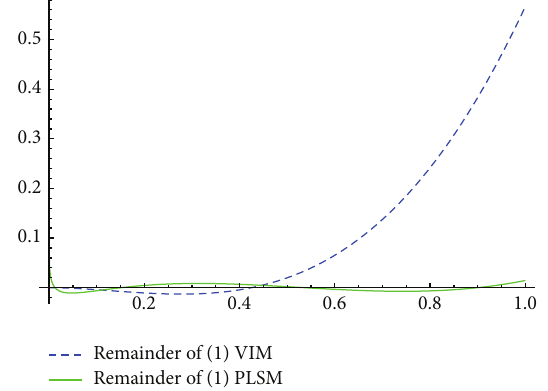
Figure 3: The remainders corresponding to the first equation for the case 𝛼 1 = 𝛼 2 = 0.98